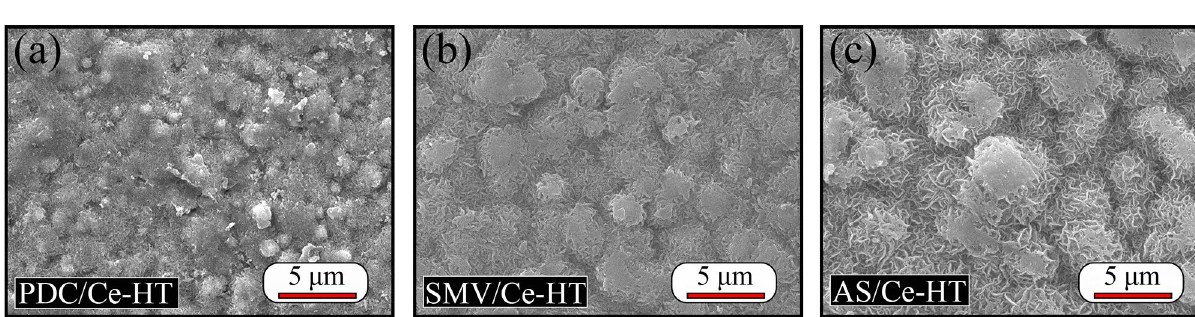
Figure 9. The SEM surface morphologies of ( a ) PDC/Ce-HT, ( b ) SMV/Ce-HT and ( c ) AS/Ce-HT